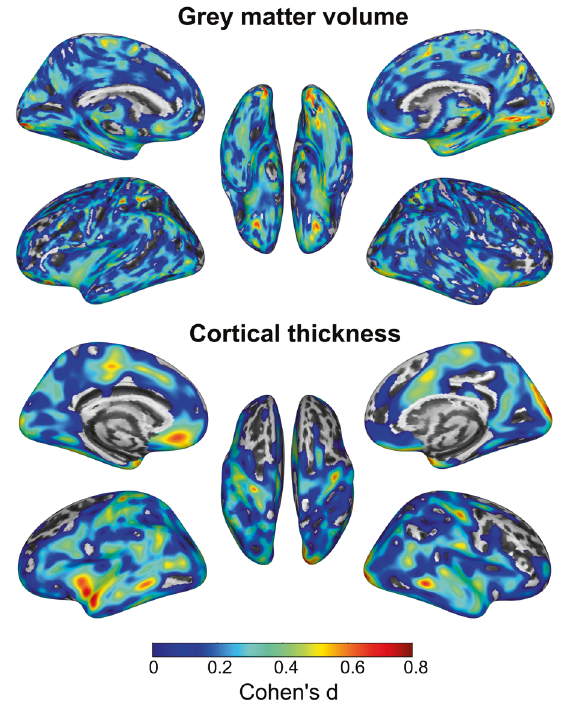
Fig. 4 Effect sizes. Illustration of the effect sizes (Cohen ’ s d ) for the difference between women with premenstrual dysphoric disorder and healthy controls in grey matter volume cortical thickness. Views of the left and right hemispheres are shown on the left and right sides, respectively. The middle brain representation shows the bottom view in the upper panel and the top view in the lower panel. Medium to large effect sizes are depicted in orange-red. Effect size maps were generated using the CAT12 toolbox (http://dbm.neuro.